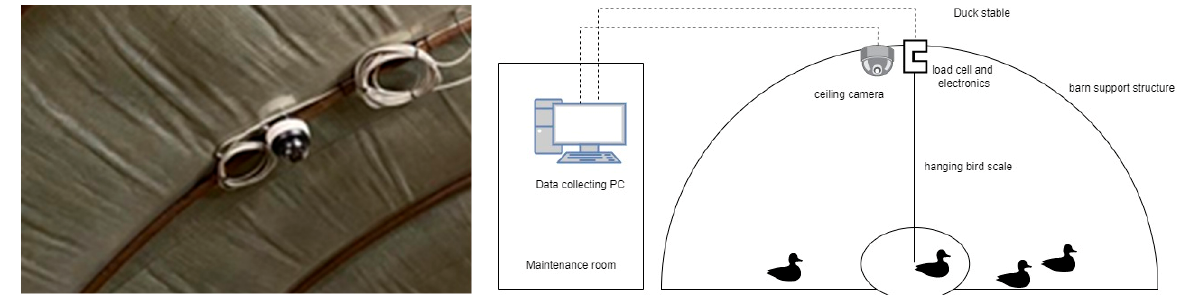
Figure 4. Attaching the camera above the bird scale to the frame of the foil tent.